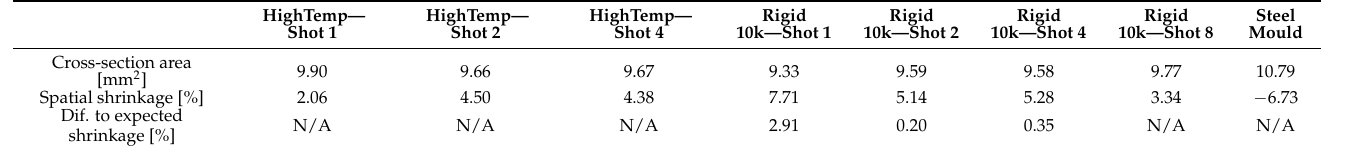
Table 5. Shrinkage of the cross-section area for PP samples moulded using different tool